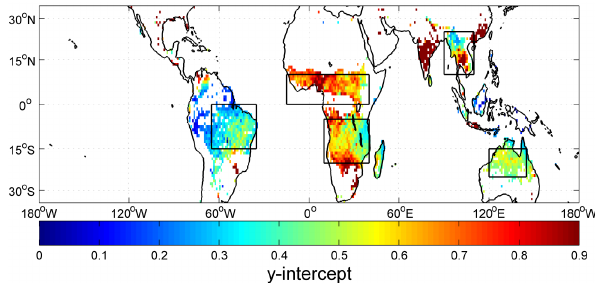
Figure 5. Mean y-intercepts [in units of 10 15 molecules cm -2 ] of the best fitting least-squares 2 Fig. 5. Mean y -intercepts (in units of 10 15 moleculescm − 2 ) of the regression lines (2007-2011) for pixels with r > 0.3, based on a 1° x 1° grid. Data are shown for 3 best fitting least-squares regression lines (2007–2011) for pixels the regression lines between GOME-2 TVC NO 2 and MODIS Terra FRP. 4 with r >0.3, based on a 1 ◦ × 1 ◦ grid. Data are shown for the regres- sion lines between GOME-2 TVC NO 2 and MODIS Terra FRP.